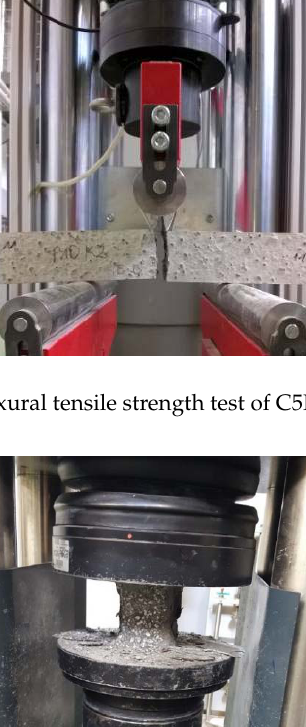
Figure 3. Compressive strength test of C15P1b concrete.